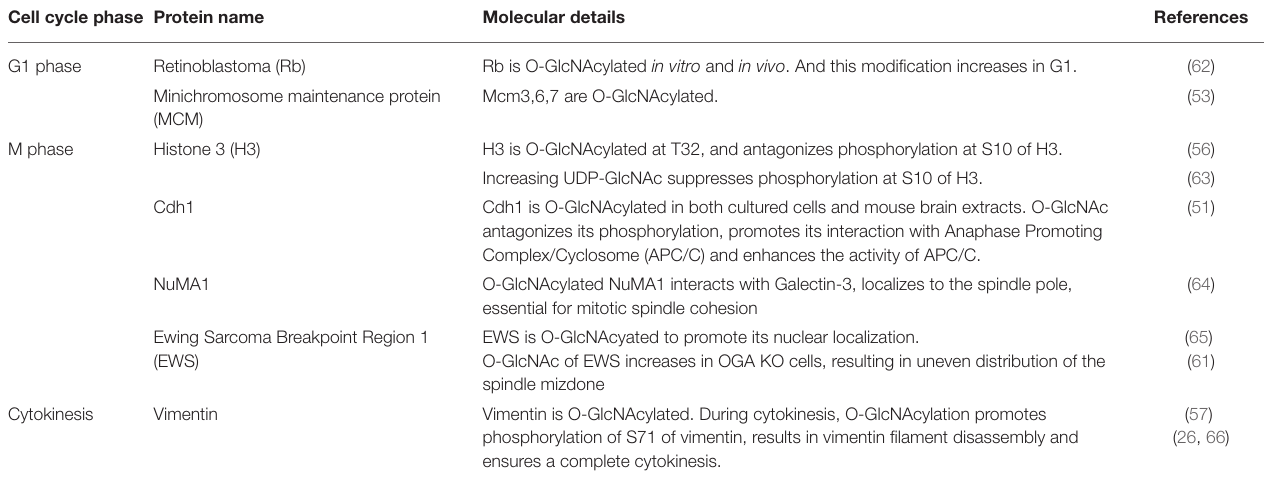
TABLE 2 | O-GlcNAcylated proteins during the unperturbed cell